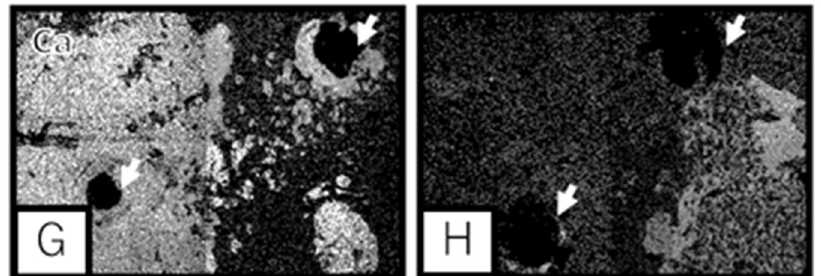
Figure 6. Scanning electron microscopic observation. Electron micrograph of Ca distribution by energy dispersive X-ray mapping of selective laser melting Ti metal. Arrows indicate screw holes. ( A ): The MAH group at 1 week. ( B ): The UN group at 1 week. ( C ): The MAH group at 4 weeks. ( D ): The UN group at 4 weeks. ( E ): The MAH group at 8 weeks. ( F ): The UN group at 8 weeks. ( G ): The MAH group at 12 weeks. ( H ): The UN group at 12 weeks.